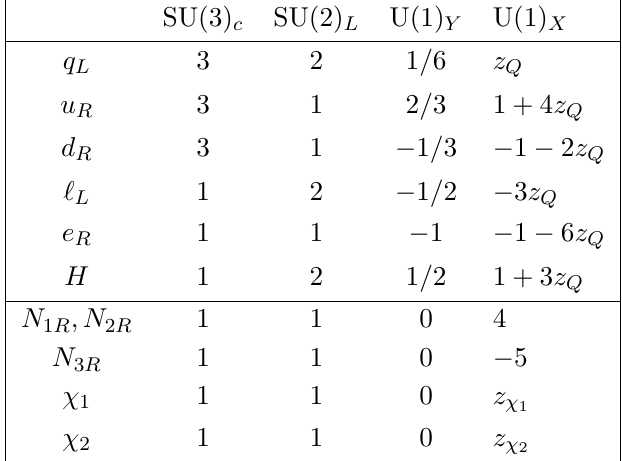
Table 1. The charge assignments for the fermions and scalars of the